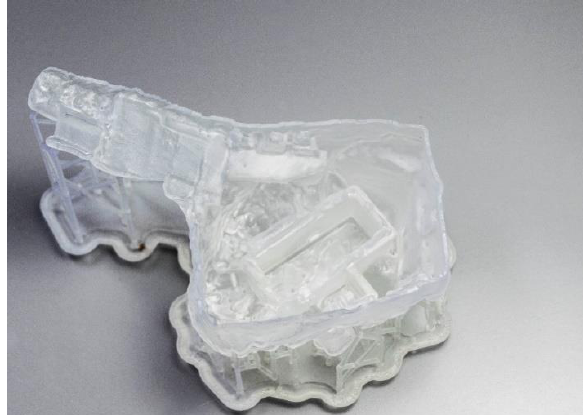
Figure 14: Model of the tomb of Ipi, Sarcophagus. SLA Resin 3D printed model. 90 x 90 x 60 mm., 2018.